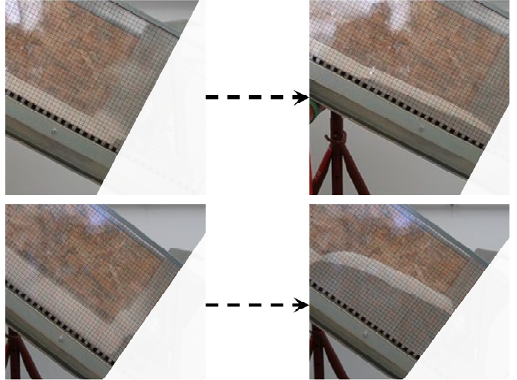
Figure 9. Phenomena of “pile-up” for inclination θ = 28.0° (above) and “run-up” for inclination θ = 35.9° (below). The figures were taken from a preliminary test with a slightly adapted test design. During the impact of the rock avalanche (dry granulate) on the rigid barriers, the defor- mation of the barrier and the dissipation of energy led to effects that reduced the maximum impact forces. The authors of [4] have already described these effects in their